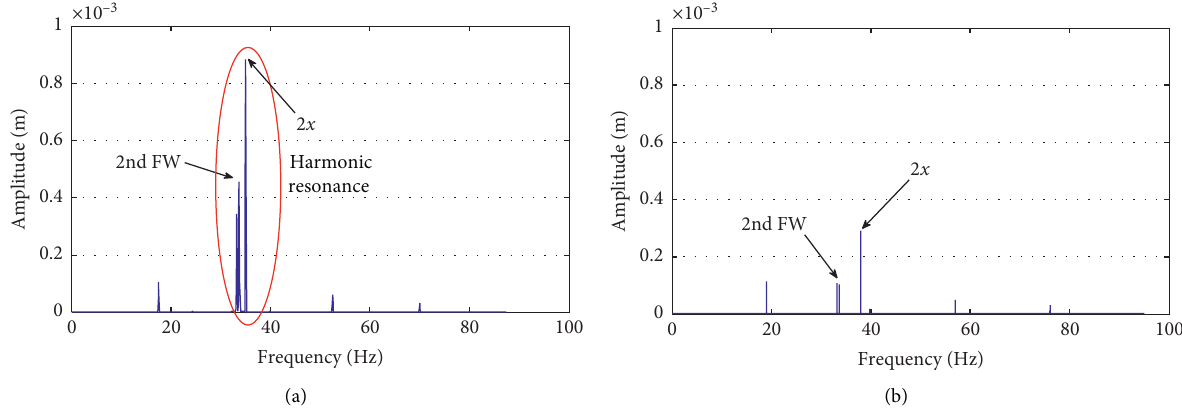
Figure 16: Resonance of 2 x in the vertical direction of bearing1: (a) 17Hz and (b) 19Hz.